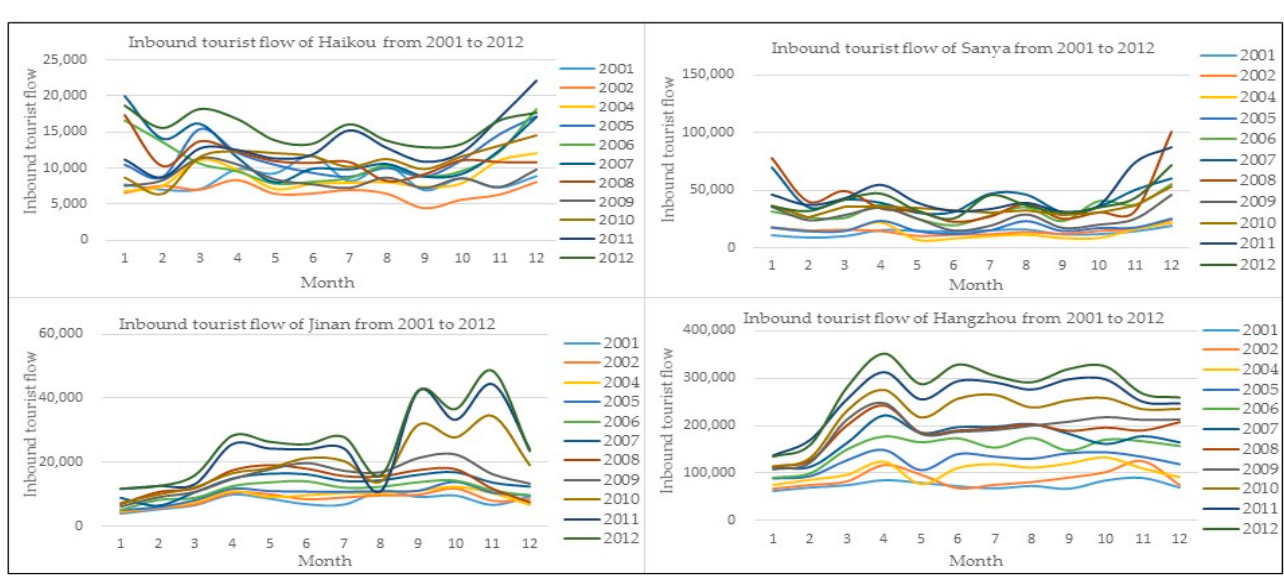
Figure 4. Three-peak. Figure 4.